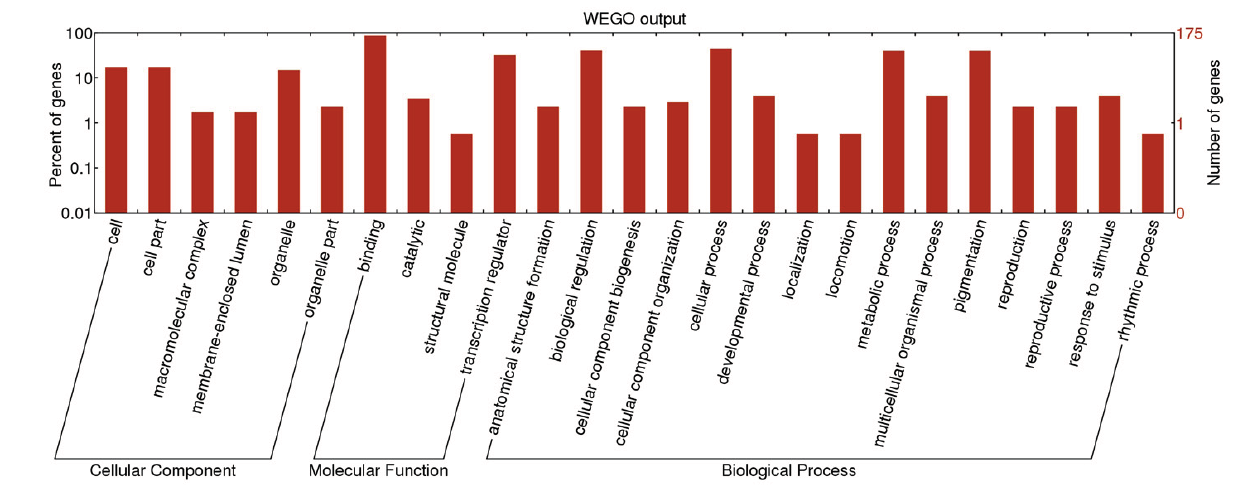
Figure 1. GO classifications of SSR containing transcription factor